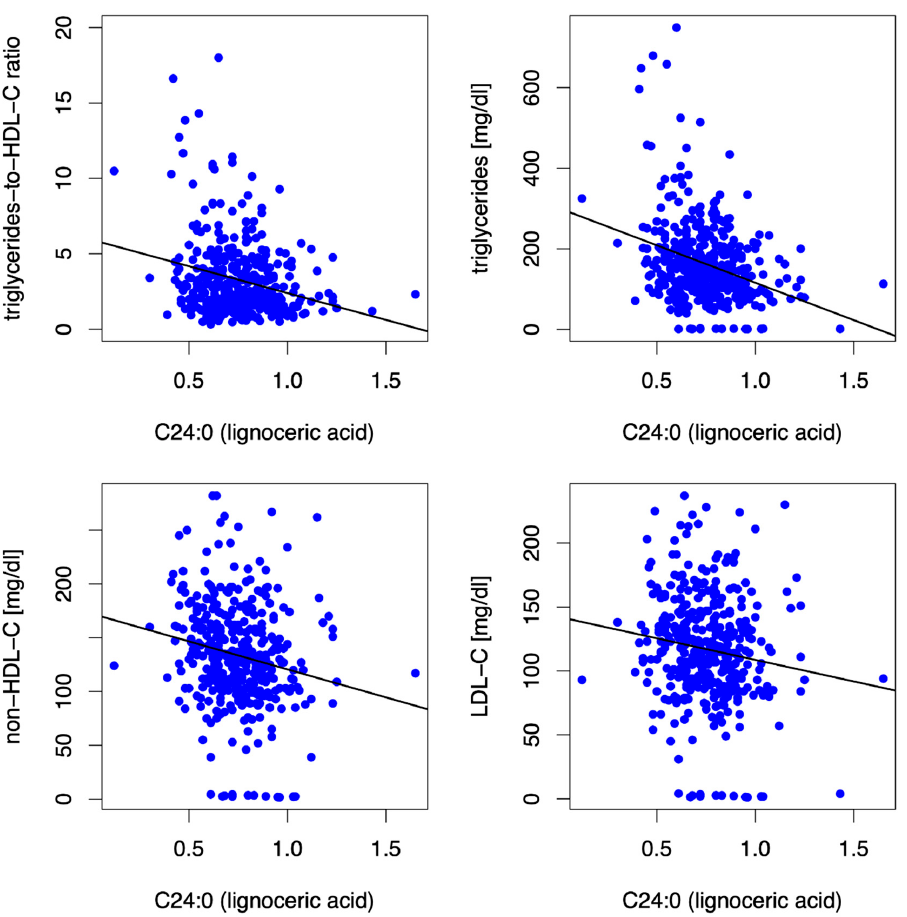
Figure 3. Scatter plots showing correlations between VLSFA lignoceric acid (C24:0) and triglycerides-to-HDL-C ratio, triglycerides, non-HDL-C, and LDL-C at baseline. The SFA lignoceric acid (C24:0) was inversely associated with triglycerides-to-HDL-C ratio, triglycerides, non-HDL-C, and LDL-C at baseline.